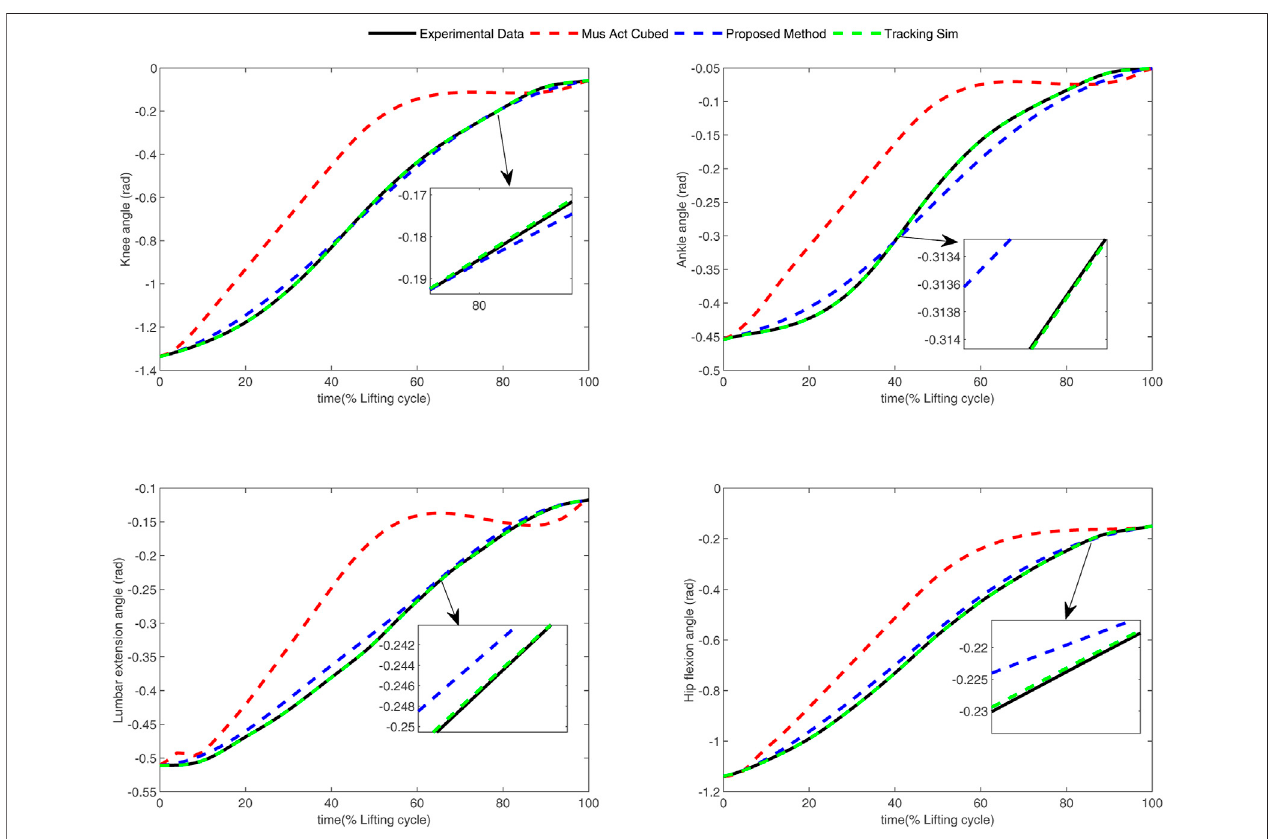
FIGURE 9 | Kinematics results of different joints obtained by different methods for subject 6.